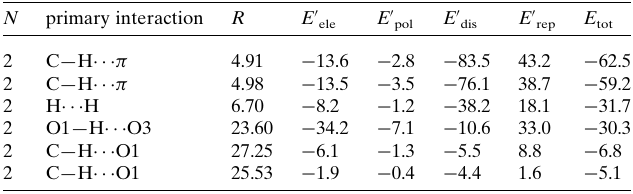
N refers to the number of molecules with an R molecular centroid-to-centroid distance (A˚ ). Energies are in kJ mol (cid:4) 1